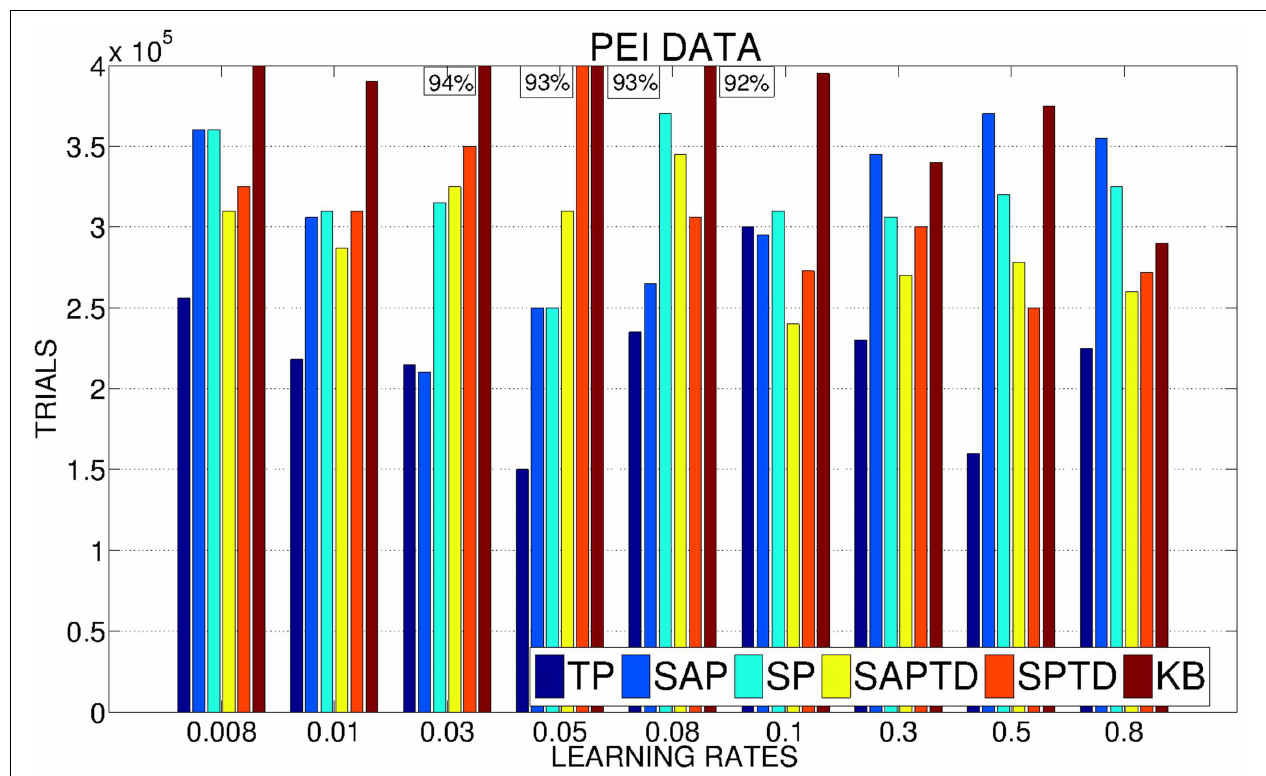
FIGURE 10 | Average number of trials needed by the system to achieve a performance in the 4 learnable tasks of 95% with different values of the learning rates of the predictors (average on 20